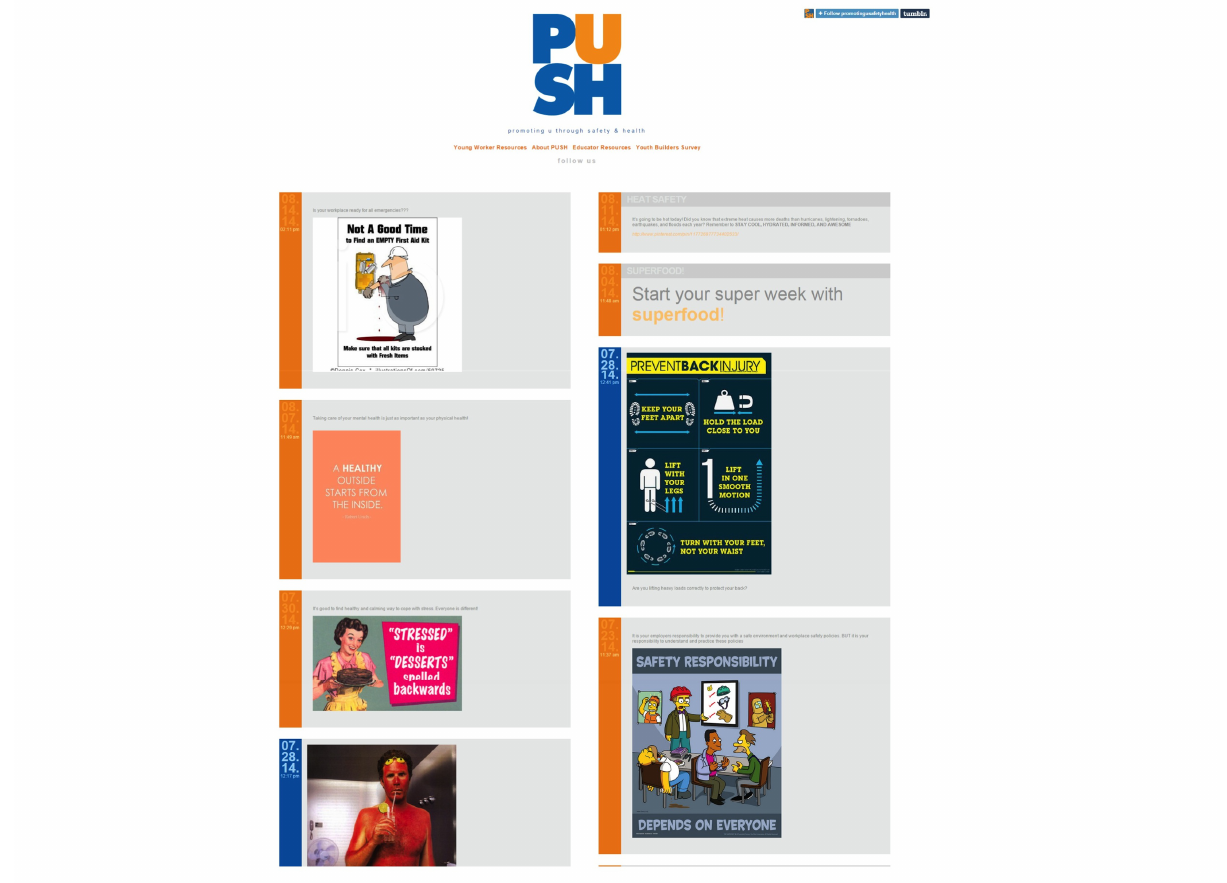
Figure 1. PUSH Tumblr site with different activities, one of which would be highlighted for assessment each